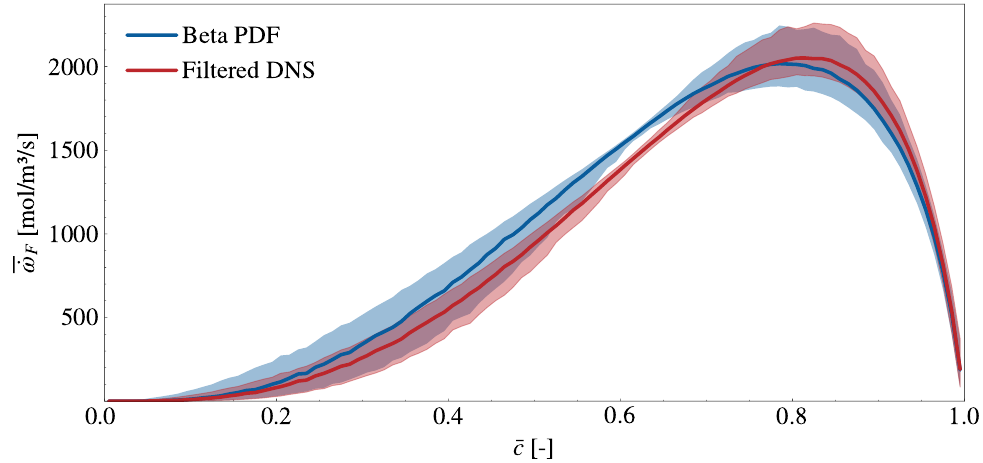
Figure 13. Distribution of the filtered reaction rate computed from a beta PDF assumption with true c (cid:48) 2 (blue) and the filtered DNS (red): conditional mean (solid line); 5% and 95% conditional quantiles (delimiting the shaded area). The statistics are aggregated over the HIT test set.